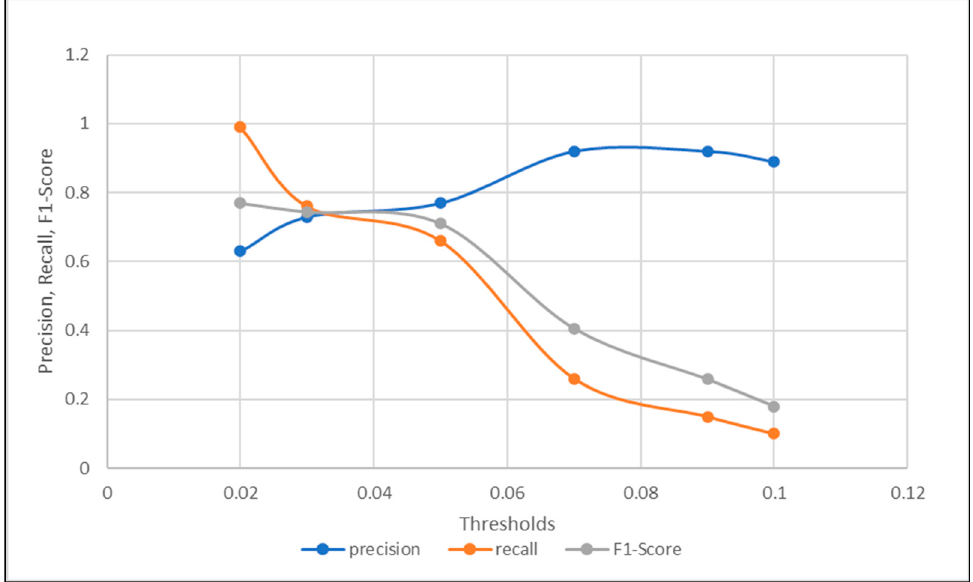
Figure 7. Precision, Recall, and f1-Score trade-off for Threshold Selection Using Signal Subtraction Difference.